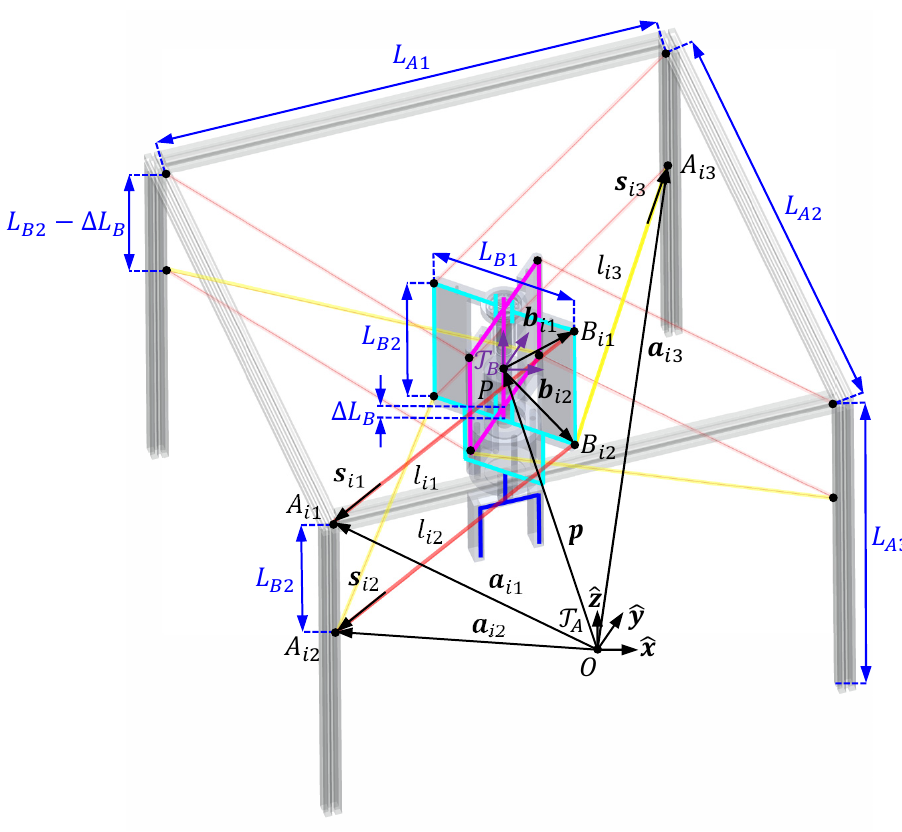
where R z ( · ) denotes the rotation matrix about the z axis, and θ 1 and θ 2 are two angles representing the orientation of the moving platform. The detailed definitions of θ 1 and θ 2 will be given in Section 2.2.